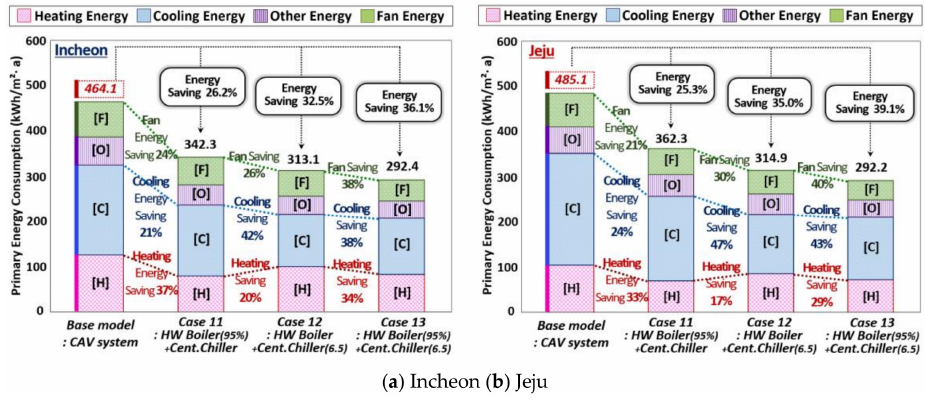
Figure 16. Primary energy consumptions and energy saving potential (%) of Case 11, Case 12, and Case 13.